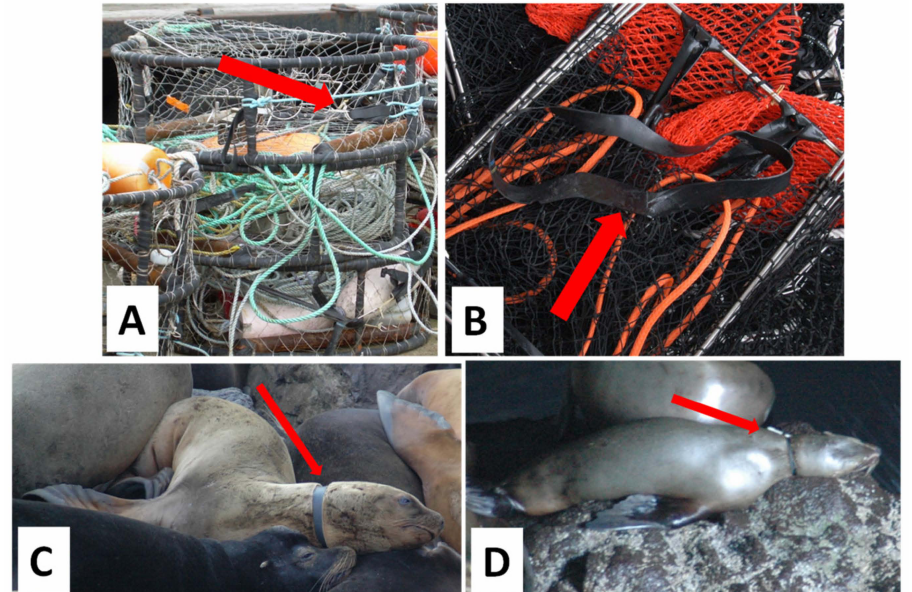
Figure 3. Examples of ( A ) commercial Dungeness crab pot with attached black rubber band, ( B ) loose rubber band lying on top of recreational crab pot aboard vessel underway, ( C ) juvenile Steller sea lion with black rubber band neck entanglement at Cascade Head, Oregon, and ( D ) juvenile Steller sea lion with black rubber band and attached white plastic hook neck entanglement at Sea Lion Caves, Oregon. Red arrows point to black rubber bands in each photo.